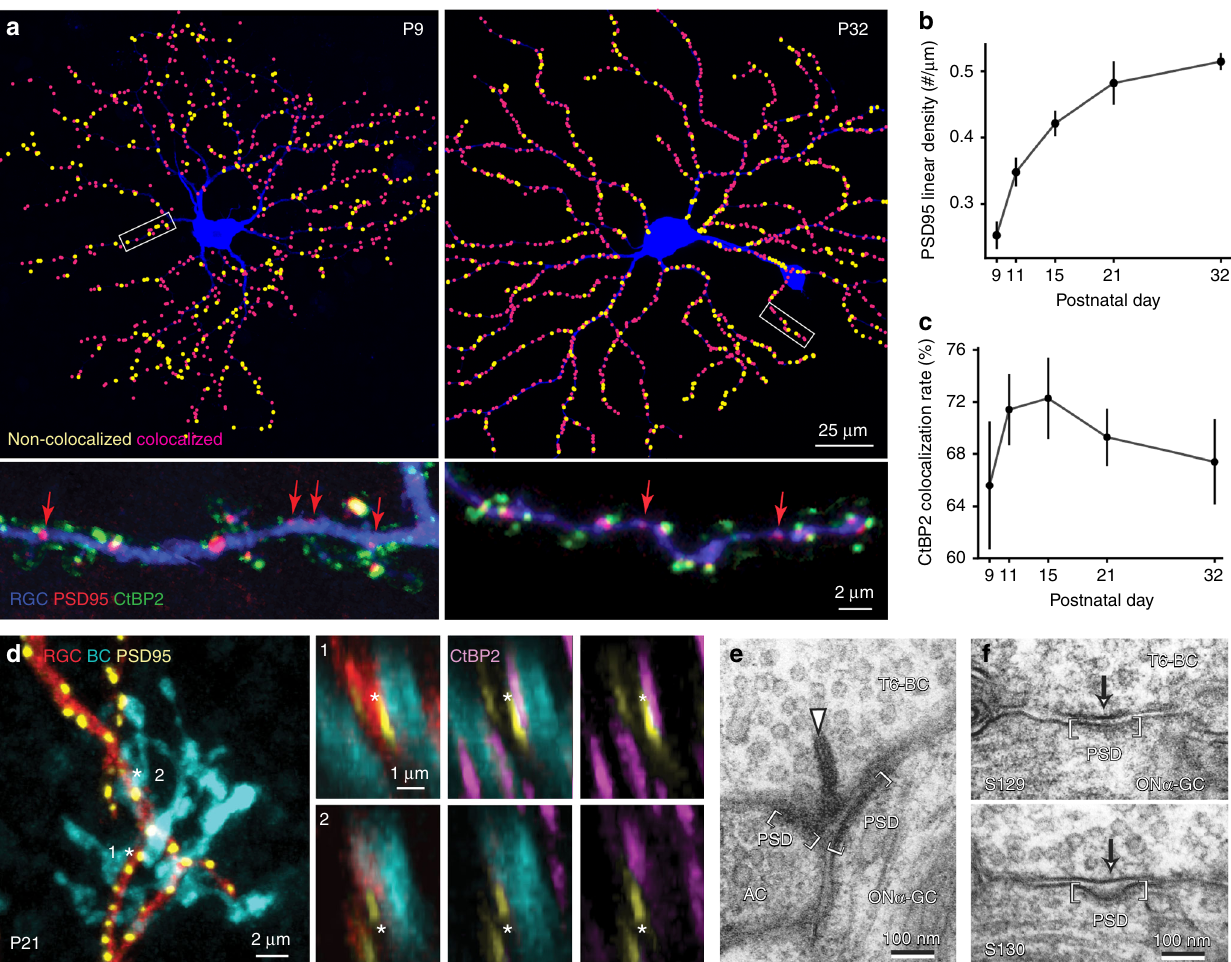
Fig. 8 BCs form ribbon-containing and ribbon-free contacts with wild-type RGCs. a (Top panels) Relationship of PSD95-YFP puncta on ON-alpha RGCs (blue) with ribbons (CtBP2 labeling) at P9 and P32. Contact sites with PSD95-YFP and CtBP2 apposed are indicated as ‘ colocalized ’ (magenta) whereas PSD95-YFP sites without CtBP2 are marked as ‘ non-colocalized ’ (yellow). (Bottom panels) Magni fi ed views of the stretch of dendrite within the rectangles. Red arrows indicate PSDS95 puncta not apposed to CtBP2 puncta. b Developmental increase of PSD95 density on the dendrites of ON-alpha RGCs. c Percentage of CtBP2 puncta apposed to PSD95 puncta on the dendrites of ON-alpha RGCs across development. N = 4 – 6 cells from 3 – 6 retinas. d Maximum intensity projections of confocal image stacks of en face views of T6 BC axon terminals and the dendrites and PSD95 puncta of an ON-alpha RGC. Two example synaptic contacts are marked with the asterisks. Magni fi ed views for both contacts are shown on the right. (1) ribbon synaptic contact; (2) ribbonless synaptic contact. e Electron micrograph showing a typical ribbon (arrowhead) synapse between a T6 BC axon and a dyad of ON-alpha RGC and amacrine cell (AC) dendrites. Both GC and amacrine cell membranes are line with PSDs (brackets). f Two consecutive electron micrographs (S129 and S130) showing a non-ribbon contact (arrows) for the same T6 BC and ON-alpha GC pair shown in e . The GC membrane is slightly concave and clearly lined by a postsynaptic density (brackets). Data are presented as mean ±